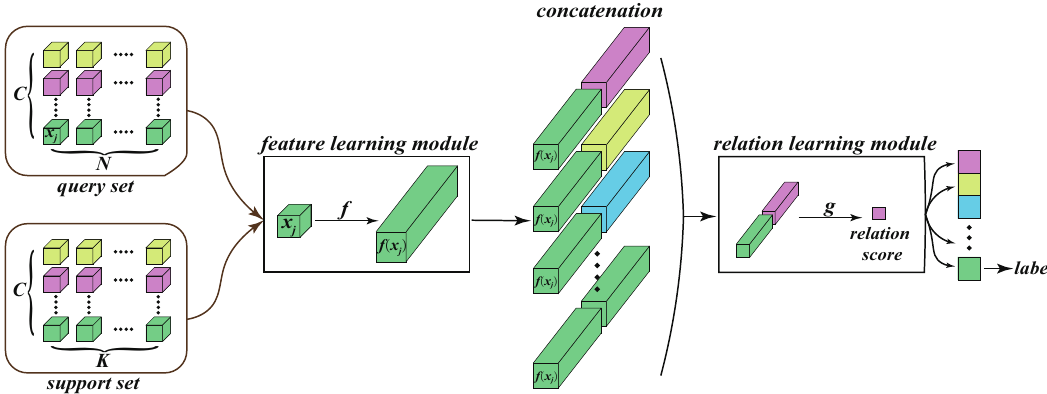
Figure 3. Visual representation of the designed relation network model for HSI few-shot